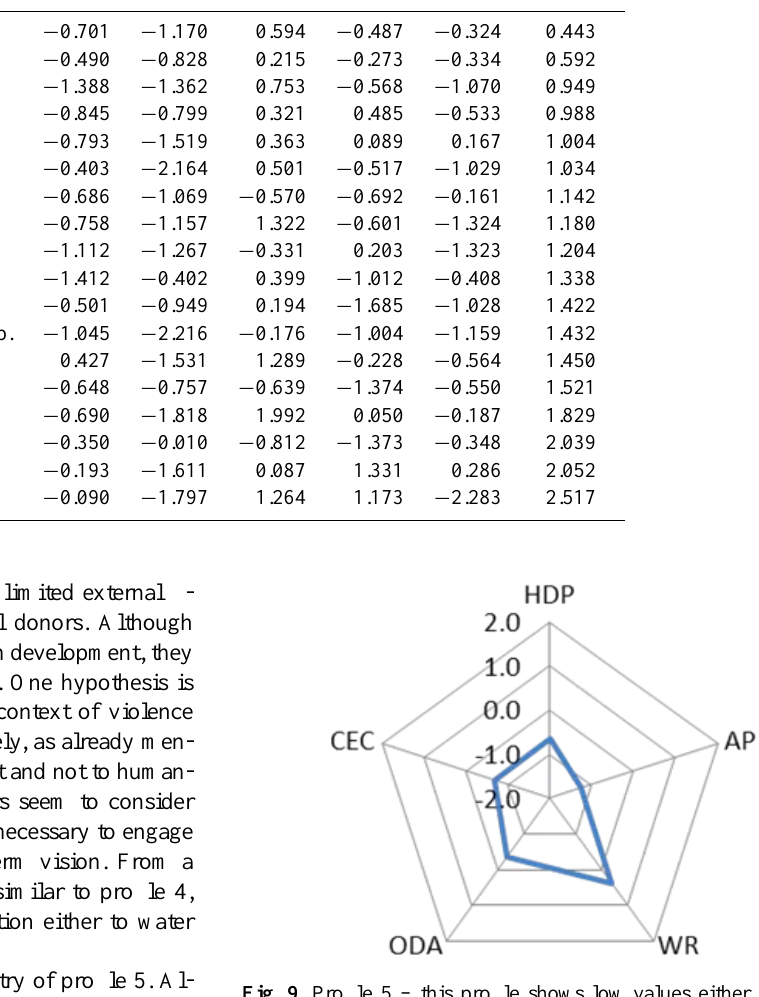
Table 11. Factors loadings and distance to centroid of the profile 5. Equatorial Guinea is considered outlier of the cluster, showing divergence with the average value of the profile. Observation HDP